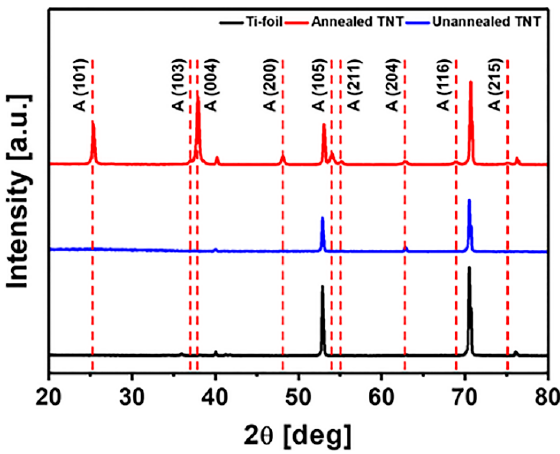
Figure 3. XRD patterns of Ti foil (black), unannealed (blue) and annealed (red) TNT array. The photocurrent measurement of TNT array’s photoanode with respect to time is shown in Figure S2. After illuminating for 2 min, the photocurrent of TNT array photoanode increased rapidly and reached a maximum photocurrent density of 0.11088 mA cm − 2 . This was followed by a fall in photocurrent density to 0.10212 mA cm − 2 ; a value obtained after 13 min of illumination. Beyond this,